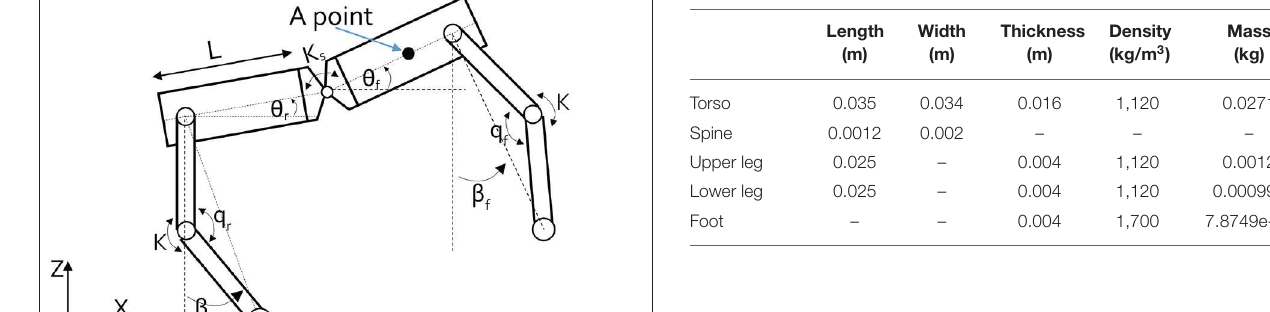
TABLE 1 | Characteristics of the